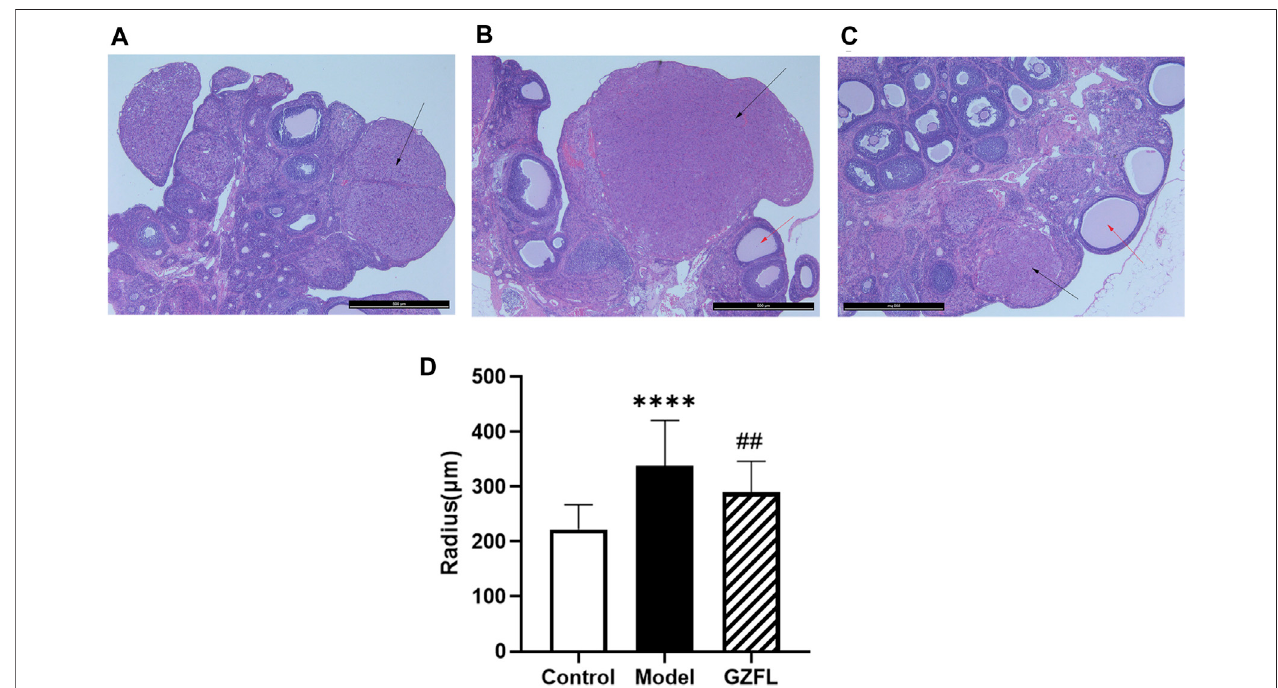
FIGURE 4 | Typical ovarian histopathology section, The black arrow represents the corpus luteum, the red arrow represents atretic follicles (A) Control group (B) Modelcontrolgroup (C) GZFLgroup (D) Ratcorpusluteumradius(x ± s ,n (cid:2) 6,compared withcontrolgroup:* p < 0.05** p < 0.01*** p < 0.001**** p < 0.0001;compared